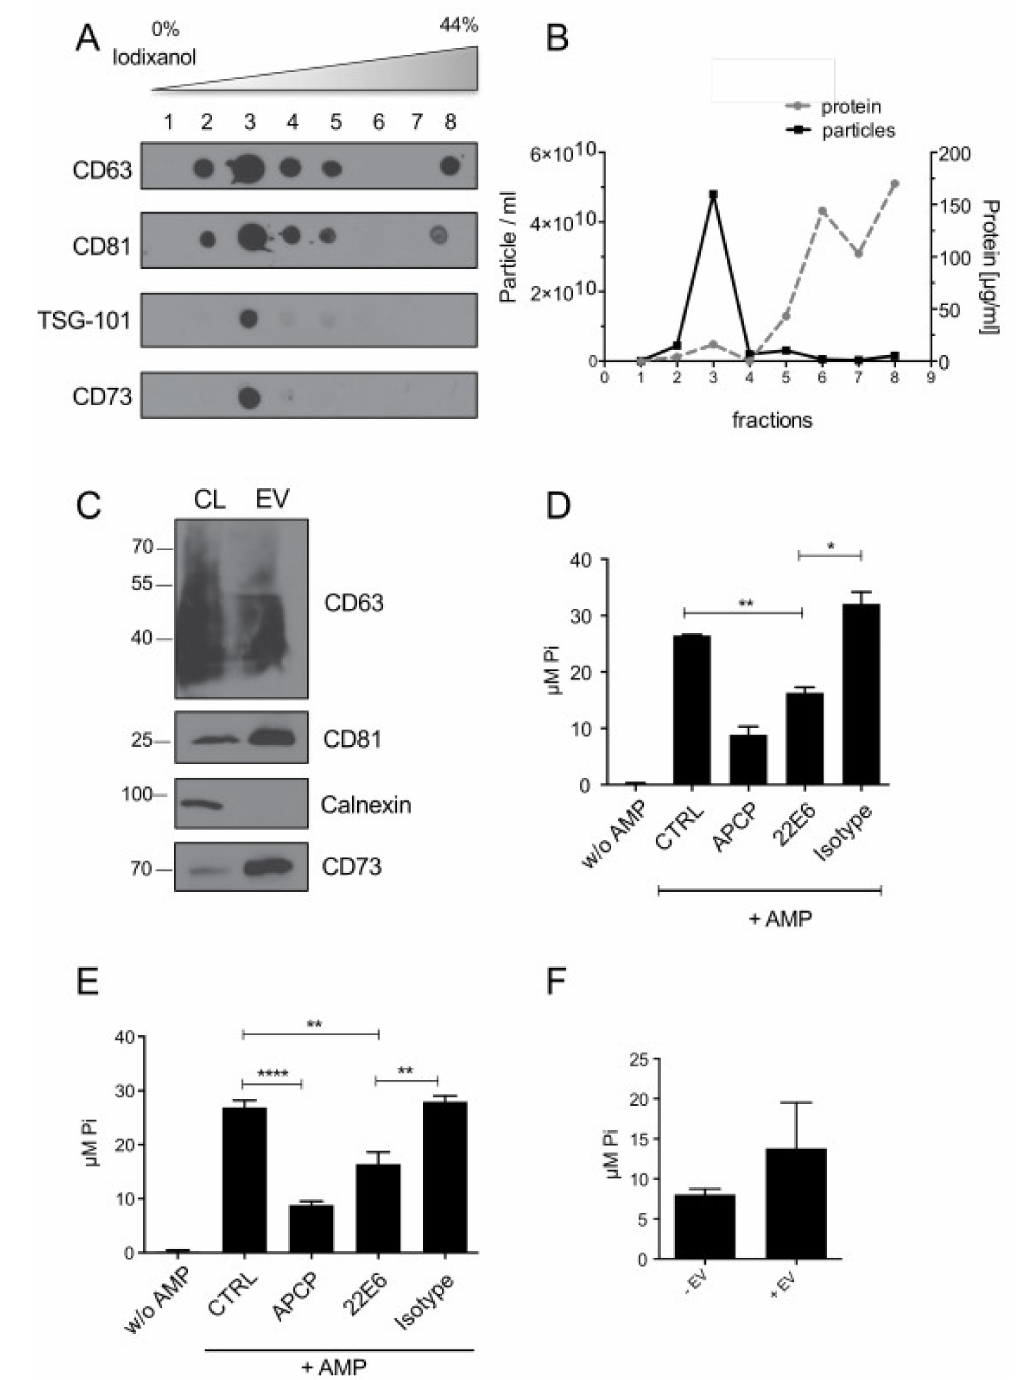
Figure 3. 22E6 blocks CD73 enzyme activity on tumor-derived extracellular vesicles. ( A ) TEVs from GBM20 cells were floated into a Optiprep gradient and separated into eight fractions, which were subsequently tested for the presence of the EV markers CD63, CD81 and TSG-101, as well as of CD73. ( B ) Particle numbers in fractions 1 to 8 were counted by NTA, and the protein content was measured in a Bradford assay. ( C ) Fraction 3 contains vesicles which stain positive for CD63, CD81 and CD73, while it is negative for Calnexin indicative for a cell-free preparation. ( D ) APCP and 22E6 block CD73 activity on TEVs from GBM20 cells and ( E ) isolated from primary ascites from a patient with ovarian cancer. ( F ) enzyme activity can be transferred by CD73-positive TEVs from GBM20 cells onto CD73-negative T47-D cells. Experiments were performed at least three times. * p < 0.05; ** p < 0.01; **** p <